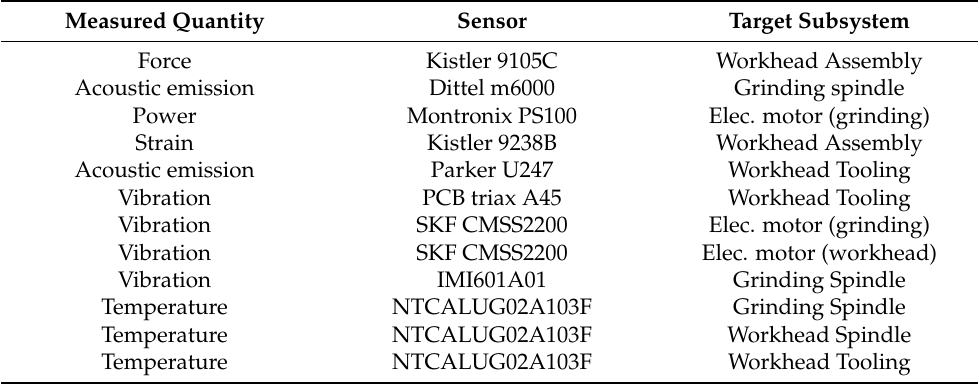
Table 1. List of sensors installed in SGB55